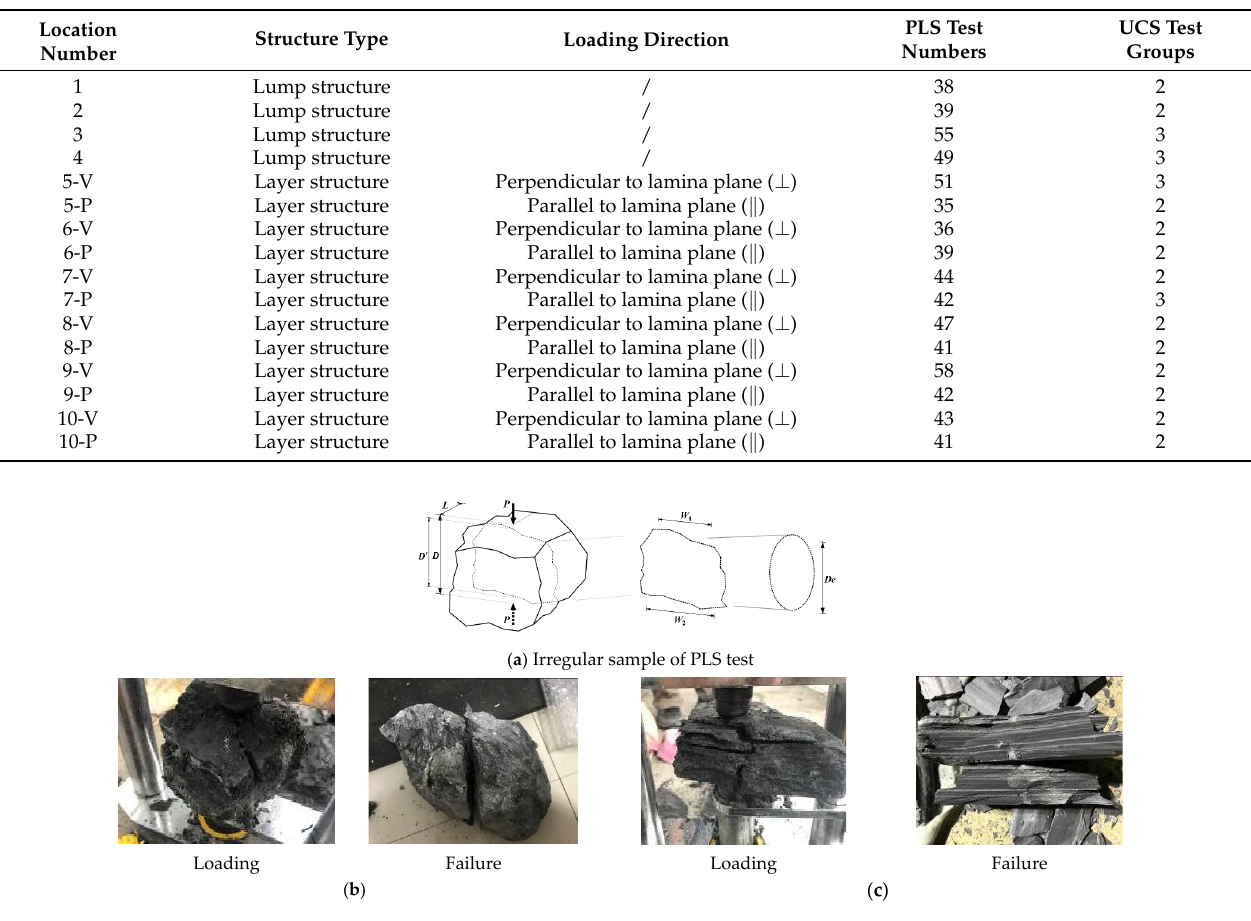
Table 1. Numbers of different locations’ carbonaceous slate samples.